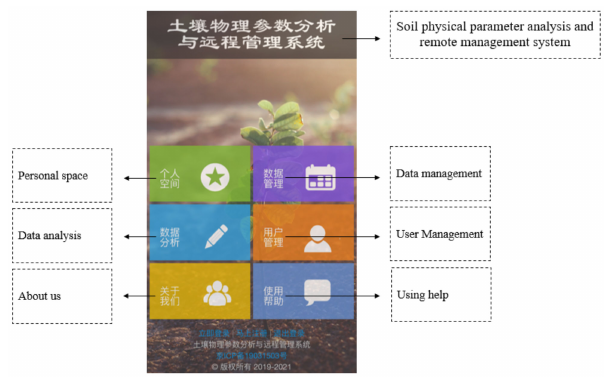
Figure 6. Mobile phone interface.